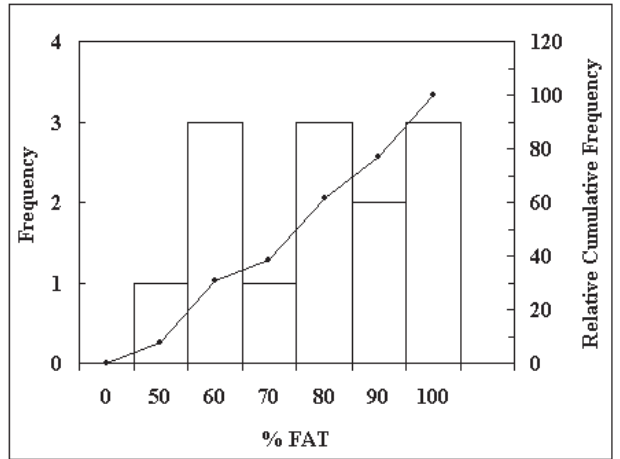
Fig. 13. Distribution of absolute frequency (columns) and relative cumulated frequency (line) of the percentile of fat in the body cavity of Mycteroperca bonaci during the “correção”.